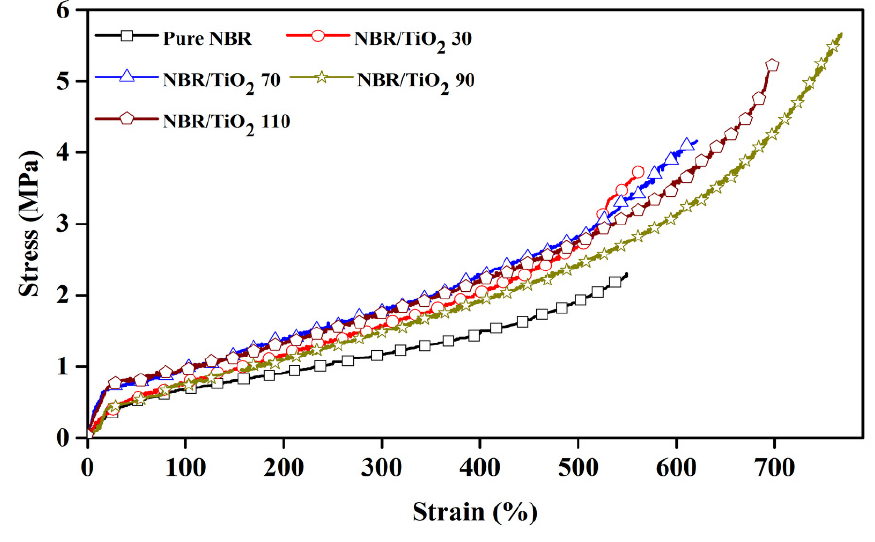
Figure 3. Stress–strain behavior of TiO 2 -filled NBR composites with various TiO 2 loadings.